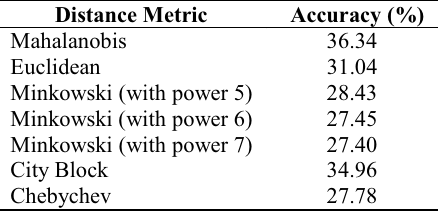
Table 7. Distance metrics using polygon area